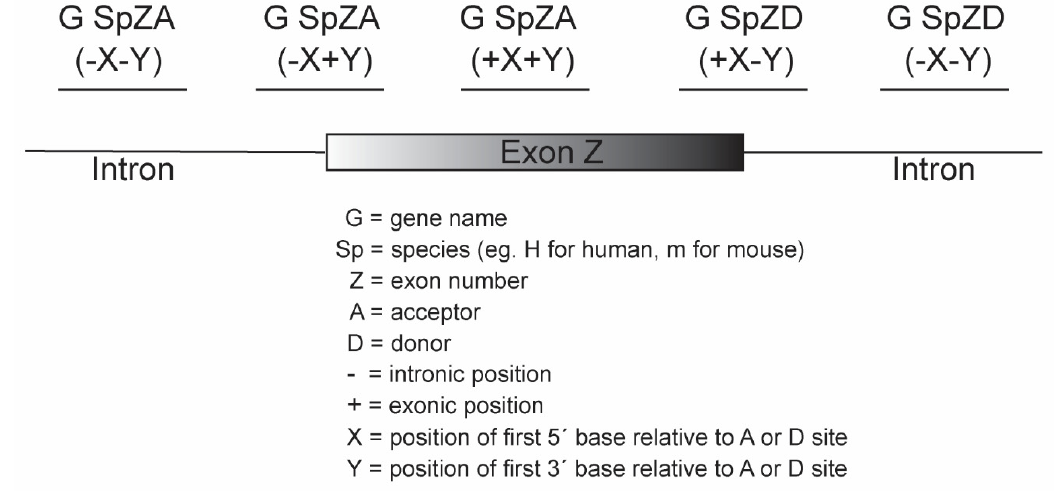
Figure 2. Nomenclature for antisense oligonucleotides.